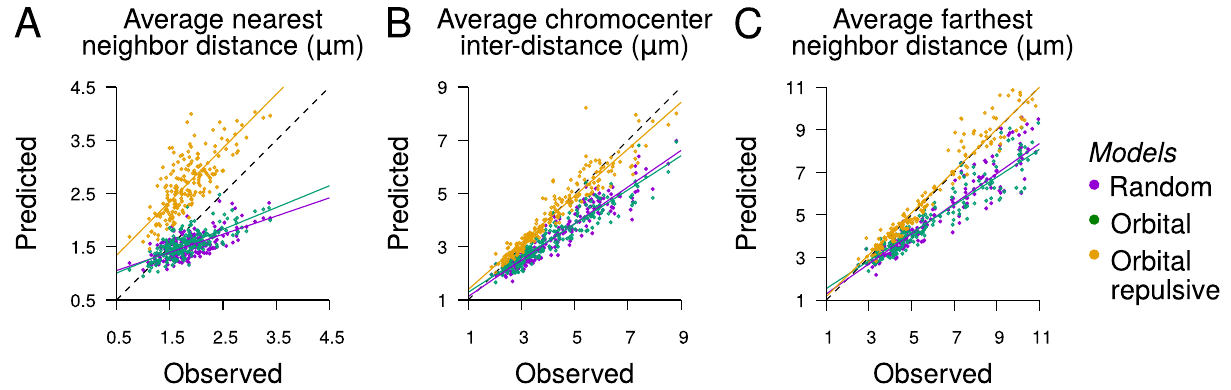
Figure 6. Observed and predicted average distances under the completely random ( Magenta ), the orbital ( Green ), and the orbital maximal repulsion ( Orange ) models. ( A ) Average distance between each chromocenter and its closest neighbor. ( B ) Average distance between pairs of chromocenters. ( C ) Average distance between each chromocenter and its farthest